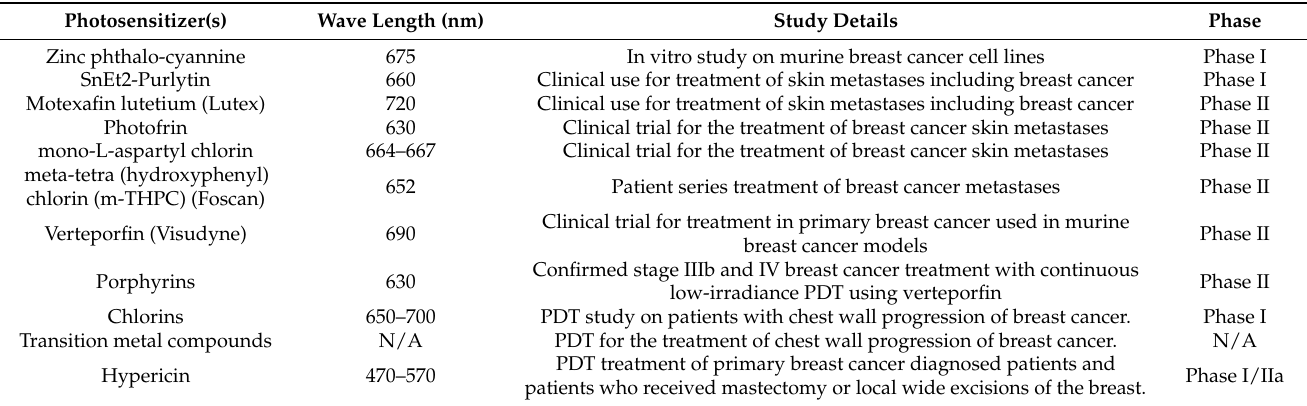
Table 2. Clinical trials on PDT of breast cancer and related